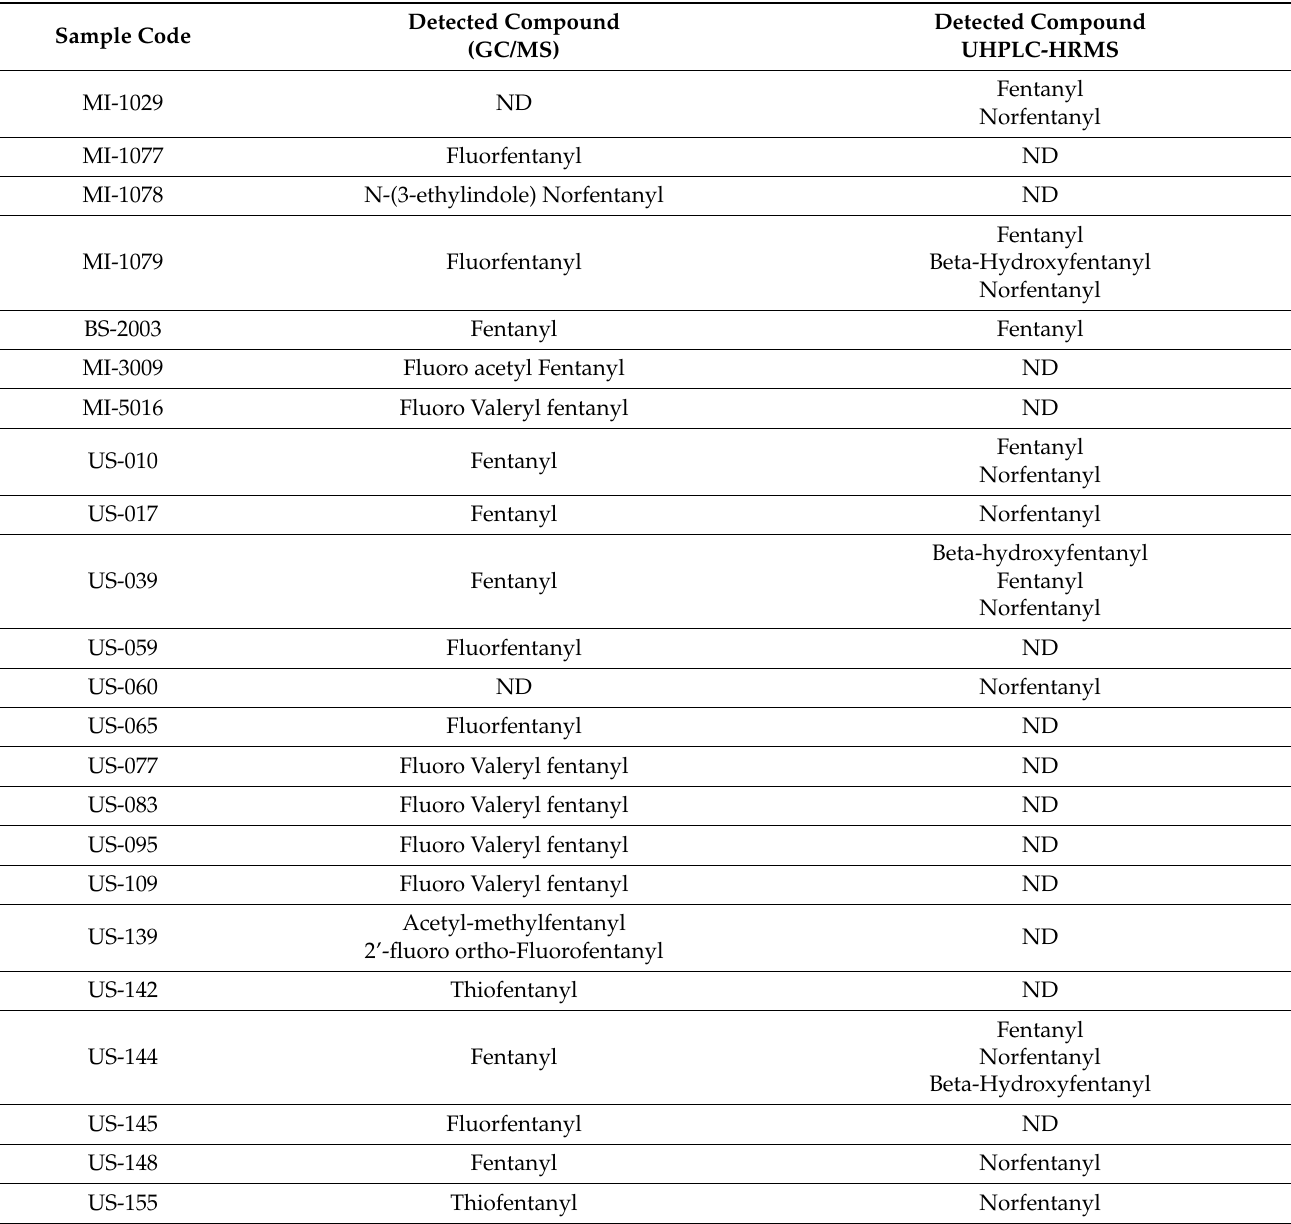
Table 2. Comparison of GC/MS and UHPLC-HRMS fentanyl and/or its metabolites and analogs urine sample screening and confirmation